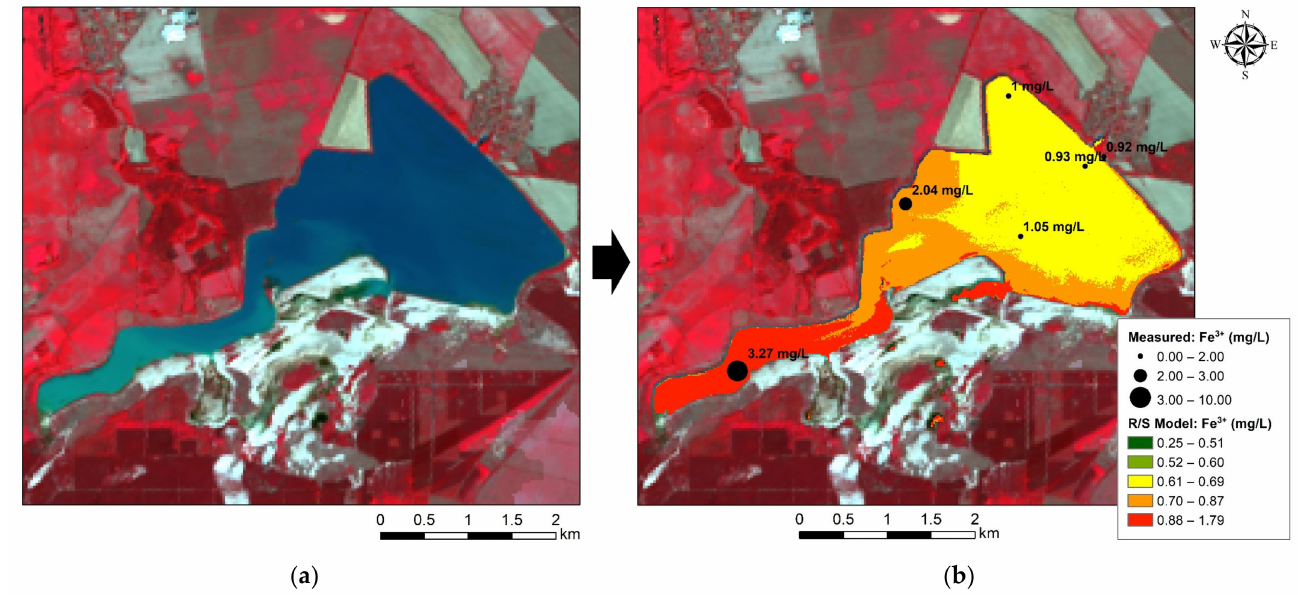
Figure 26. ( a ) False-color image over the Schlabendorfer See (bands 8-4-3) acquired in August 2020. ( b ) The AMD distribution according to the R/S